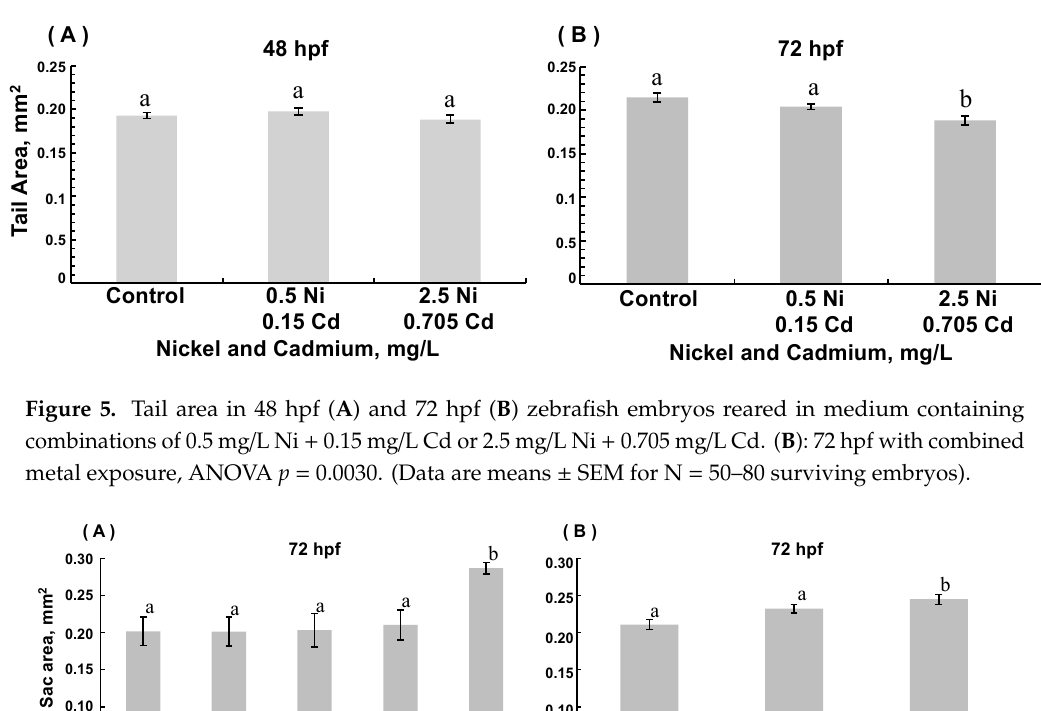
Figure 4. Trunk area in 48 hpf ( A ) and 72 hpf ( B ) zebrafish embryos reared in medium containing 0.1–5 mg/L Ni. ( A ): 48 hpf with Ni exposure, ANOVA p = 0.0187. (Data are means ± SEM for N = 50–80 surviving embryos.).